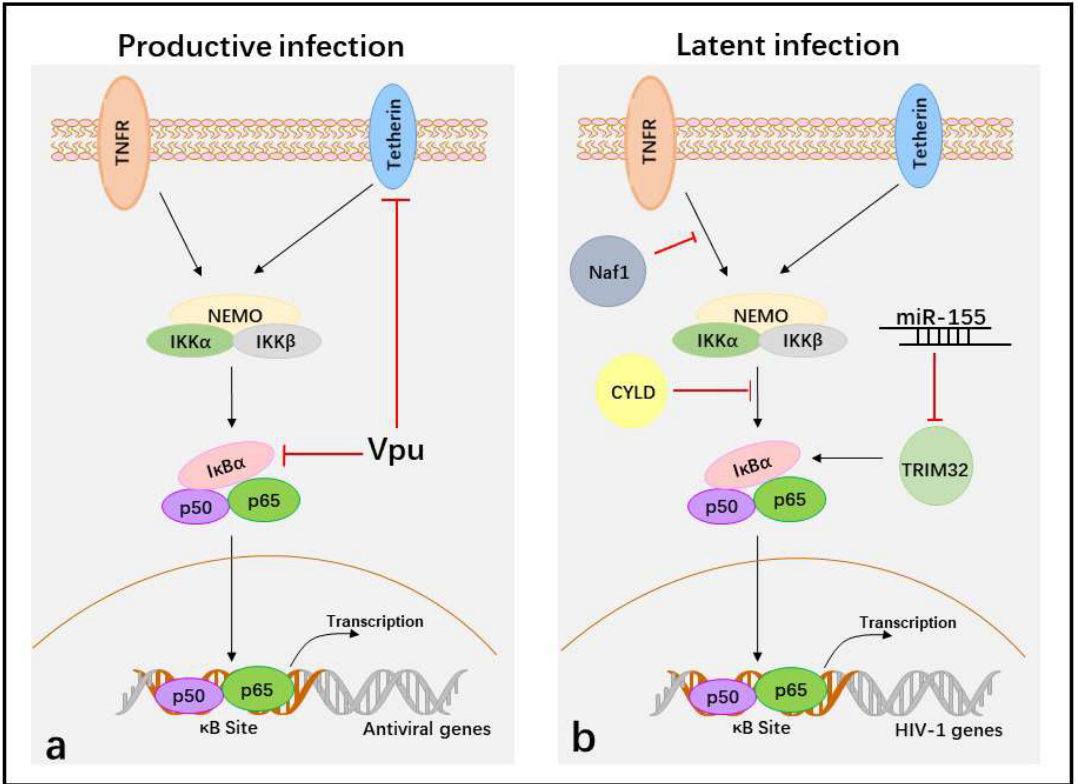
Figure 2. Suppression of the activation of NF-κB to facilitate HIV-1 immune evasion in the different life cycles. ( a ) In productive HIV-1 infection, Vpu protein targets tetherin and IκBα to block NF-κB-dependent antiviral gene transcription during later stages. ( b ) In latent infection, the cellular proteins Naf1 and CYLD inhibit NF-κB activity and block p50/p65 binding at κB sites in HIV-1 LTR to maintain HIV-1 latency, whereas miR-155 blocks p50/p65 binding at κB sites in HIV-1 LTR by targeting TRIM32. The black arrows indicate induction of NF-κB activation and red T bars indicate inhibition of NF-κB activation.